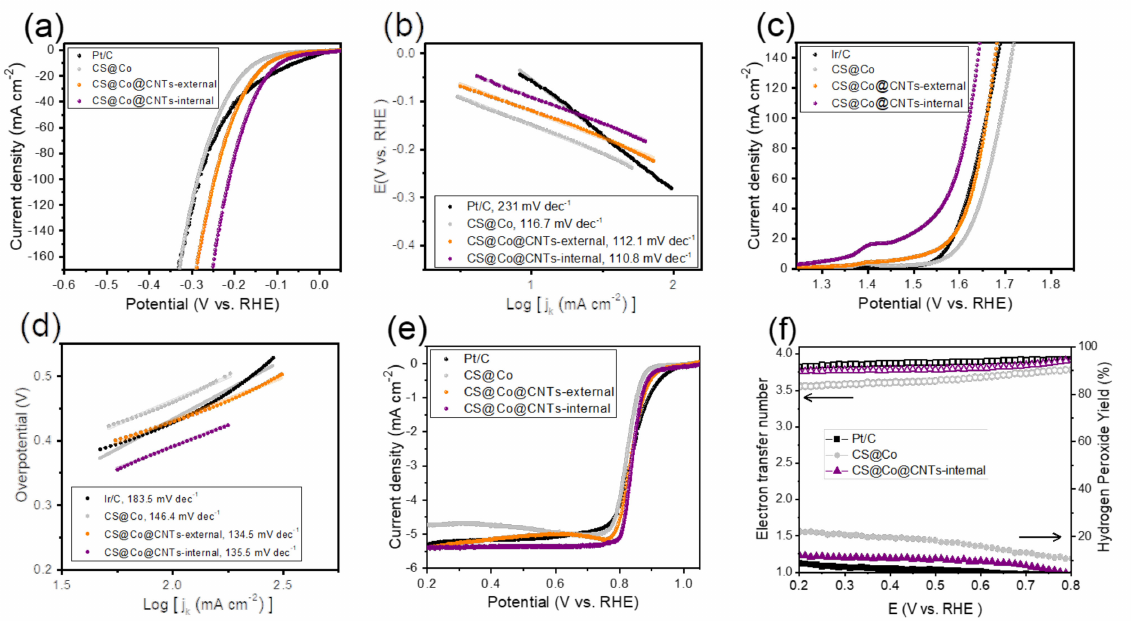
Figure 5. ( a ) LSV curves of as-prepared carbon sponge electrodes and Pt/C toward HER in 1 M KOH electrolyte with a scan rate of 1 mV s − 1 and ( b ) corresponding Tafel plots. ( c ) LSV curves of as-prepared carbon sponge electrodes and Ir/C toward OER in 1 M KOH electrolyte with a scan rate of 1 mV s − 1 and ( d ) corresponding Tafel plots. ( e ) LSV curves of samples based on RRDE experiments in O 2 -saturated 0.1 M KOH electrolyte with a scan rate of 1 mV s − 1 and at a rotating rate of 1600 rpm. ( f ) Hydrogen peroxide yields and electron transfer numbers calculated from RRDE